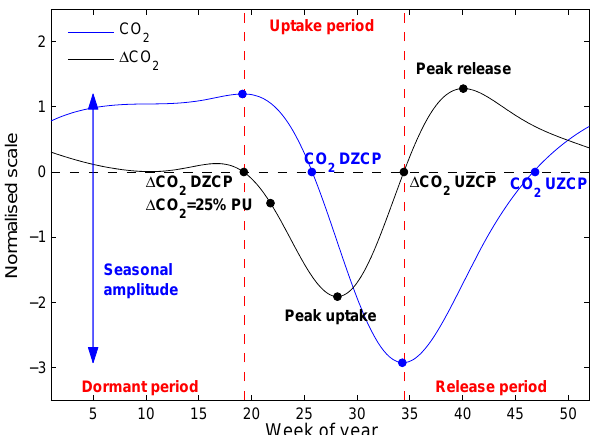
Figure 6. A schematic describing the metrics we use to characterize changes in the amplitude and phase of atmospheric CO 2 (ppm). In this example we use detrended annual and semiannual components of CO 2 data from Barrow,